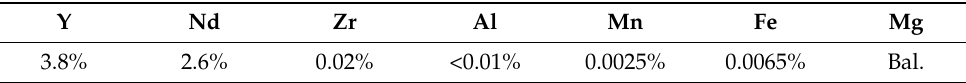
Table 1. Chemical composition of WE43 alloy.